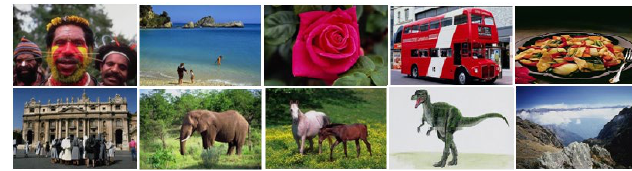
Figure 5. ( http://wang.ist.psu.edu/docs/related/) .